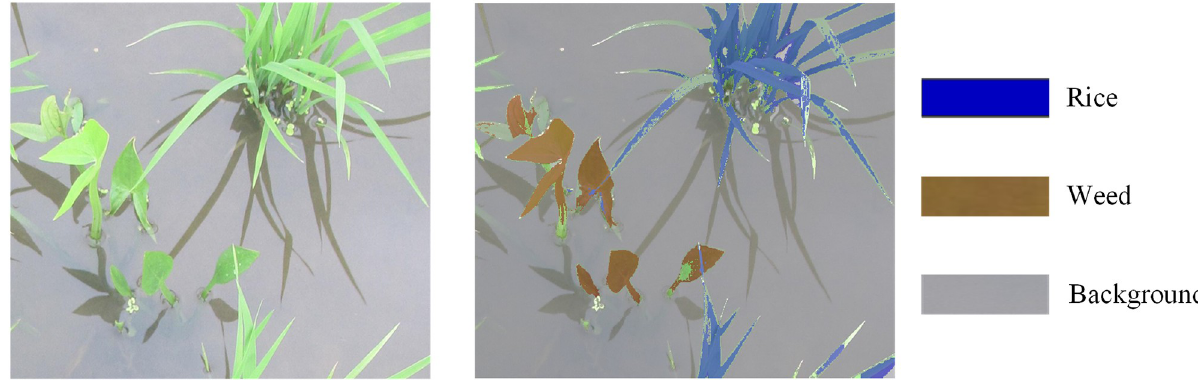
Fig 2. Image-label example. (a) original image and (b) the corresponding GT labels.